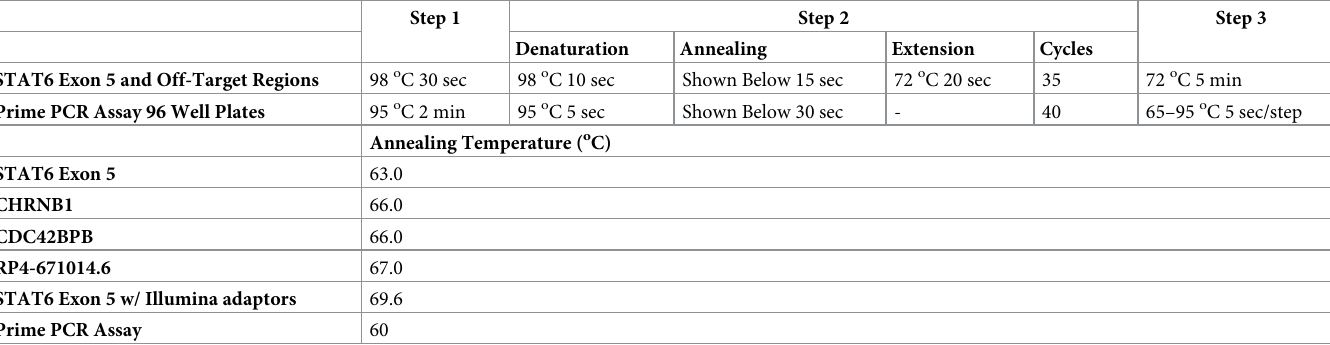
Table 2. PCR conditions for amplification of exon 5 of STAT6, off-target regions, and quantitative RT-PCR 96 wells plates.